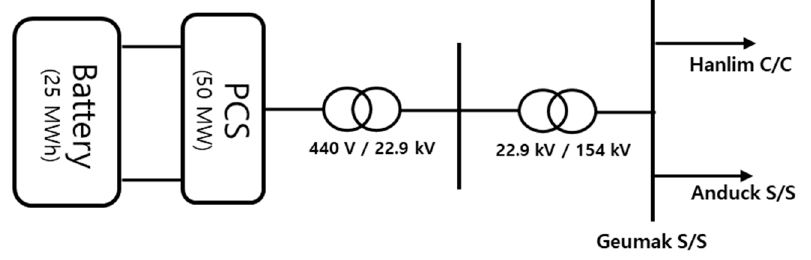
Figure 4. BESS installation at the 154-kV Geumak S / S.